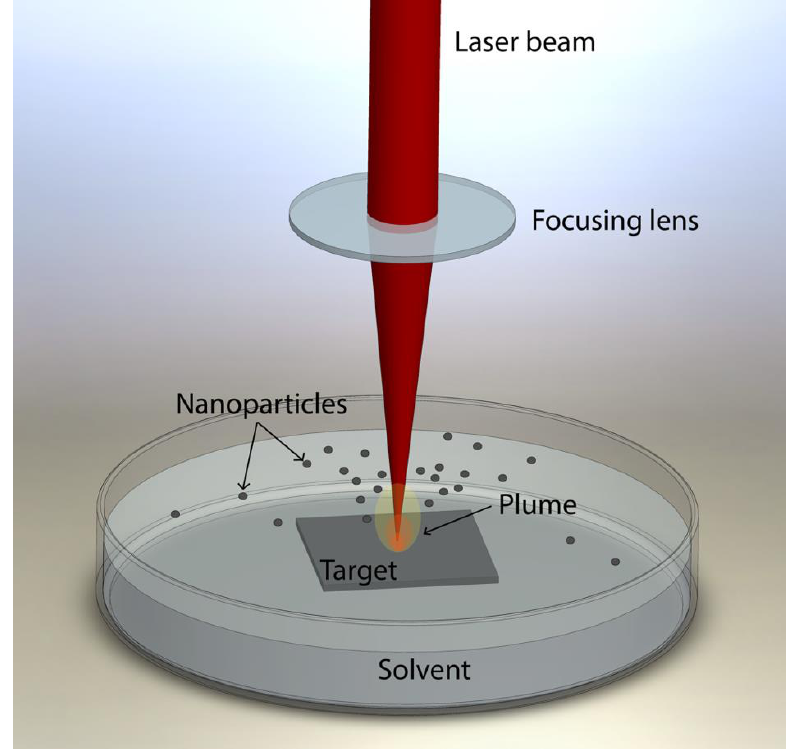
Figure 1. Laser ablation process.